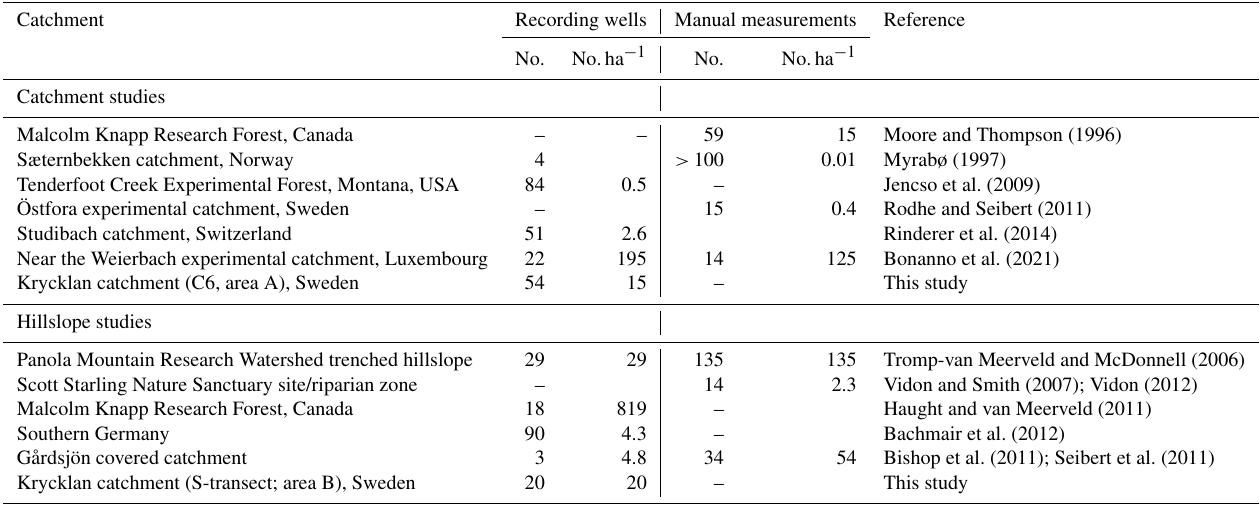
Table A1. Selected catchment and hillslope-scale studies with a large number of shallow groundwater-level measurements and reported well densities (number of wells per hectare).